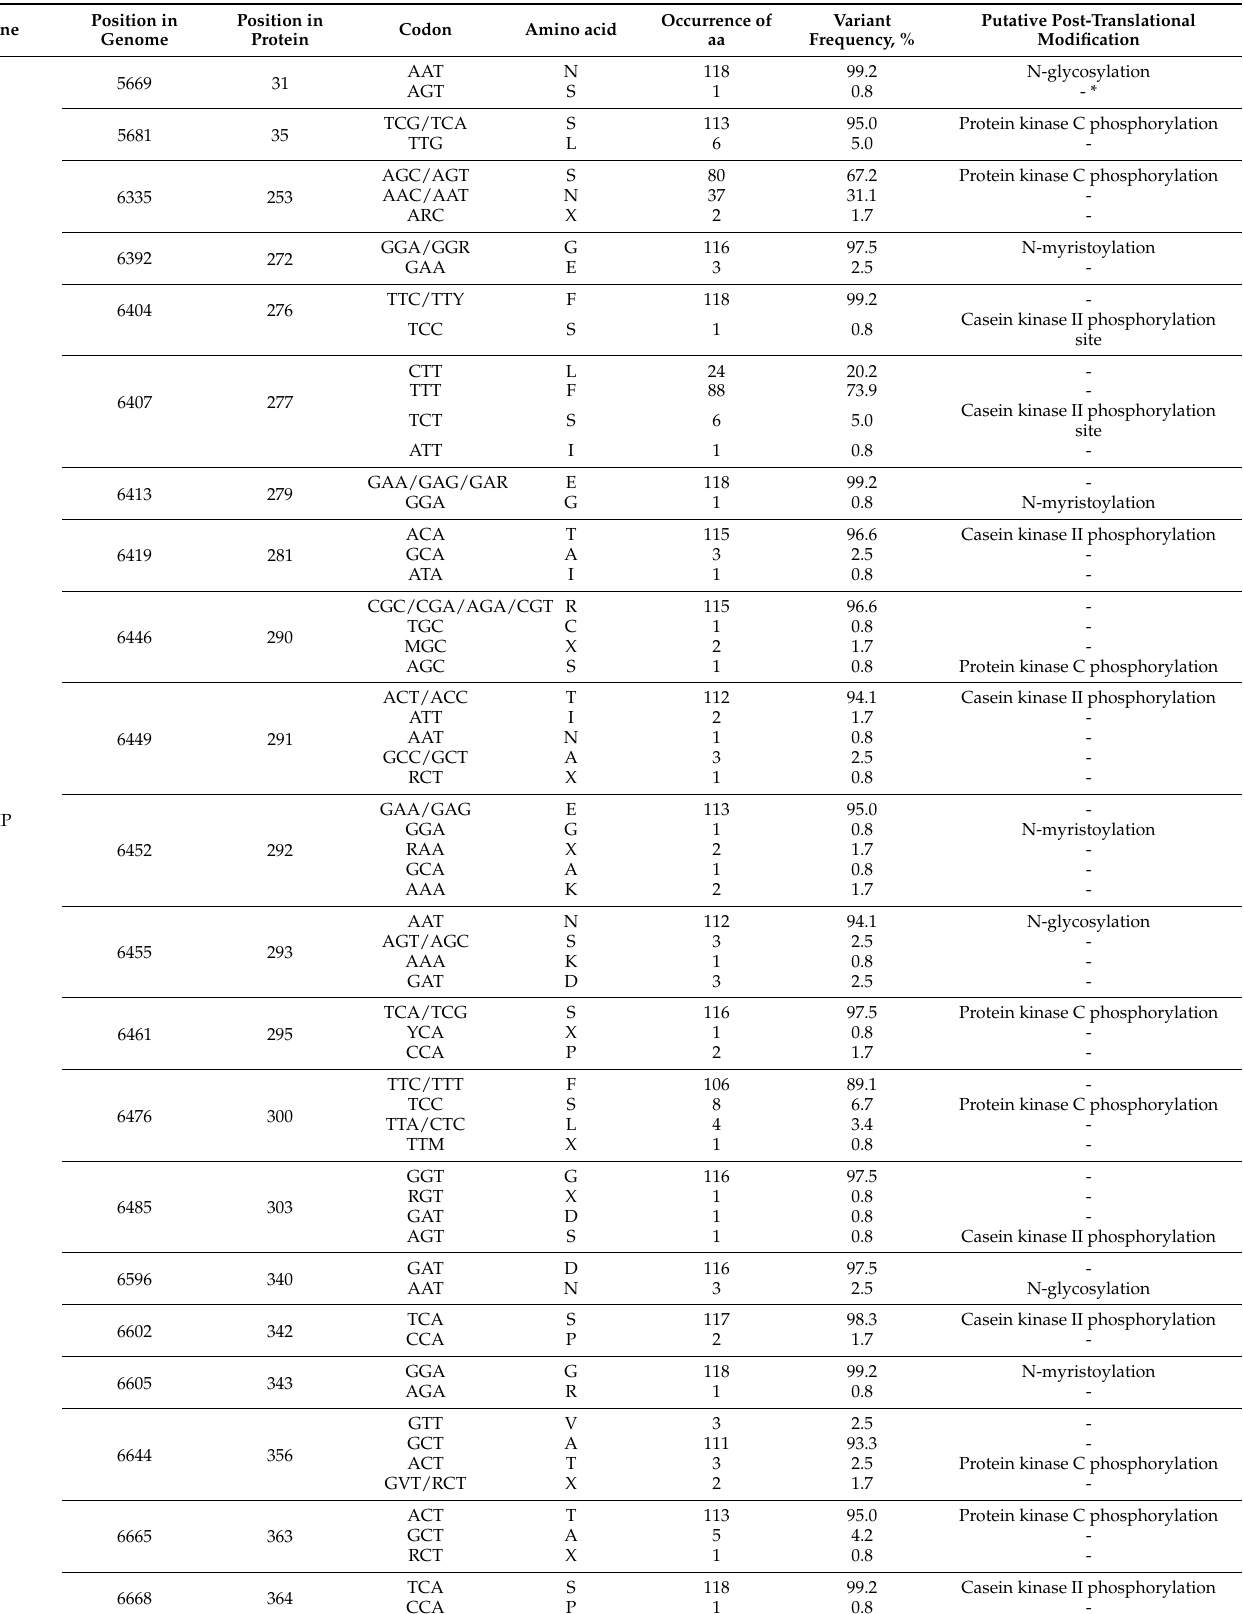
Table 2. List of the polymorphic sites of MP/CP Russian GPGV